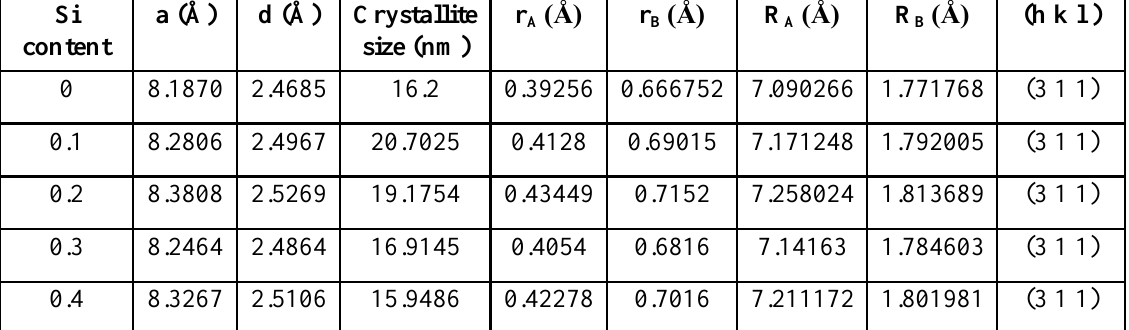
Table 2: Lattice parameter A- and B- site radii, bond length and oxygen parameter as a function of Si